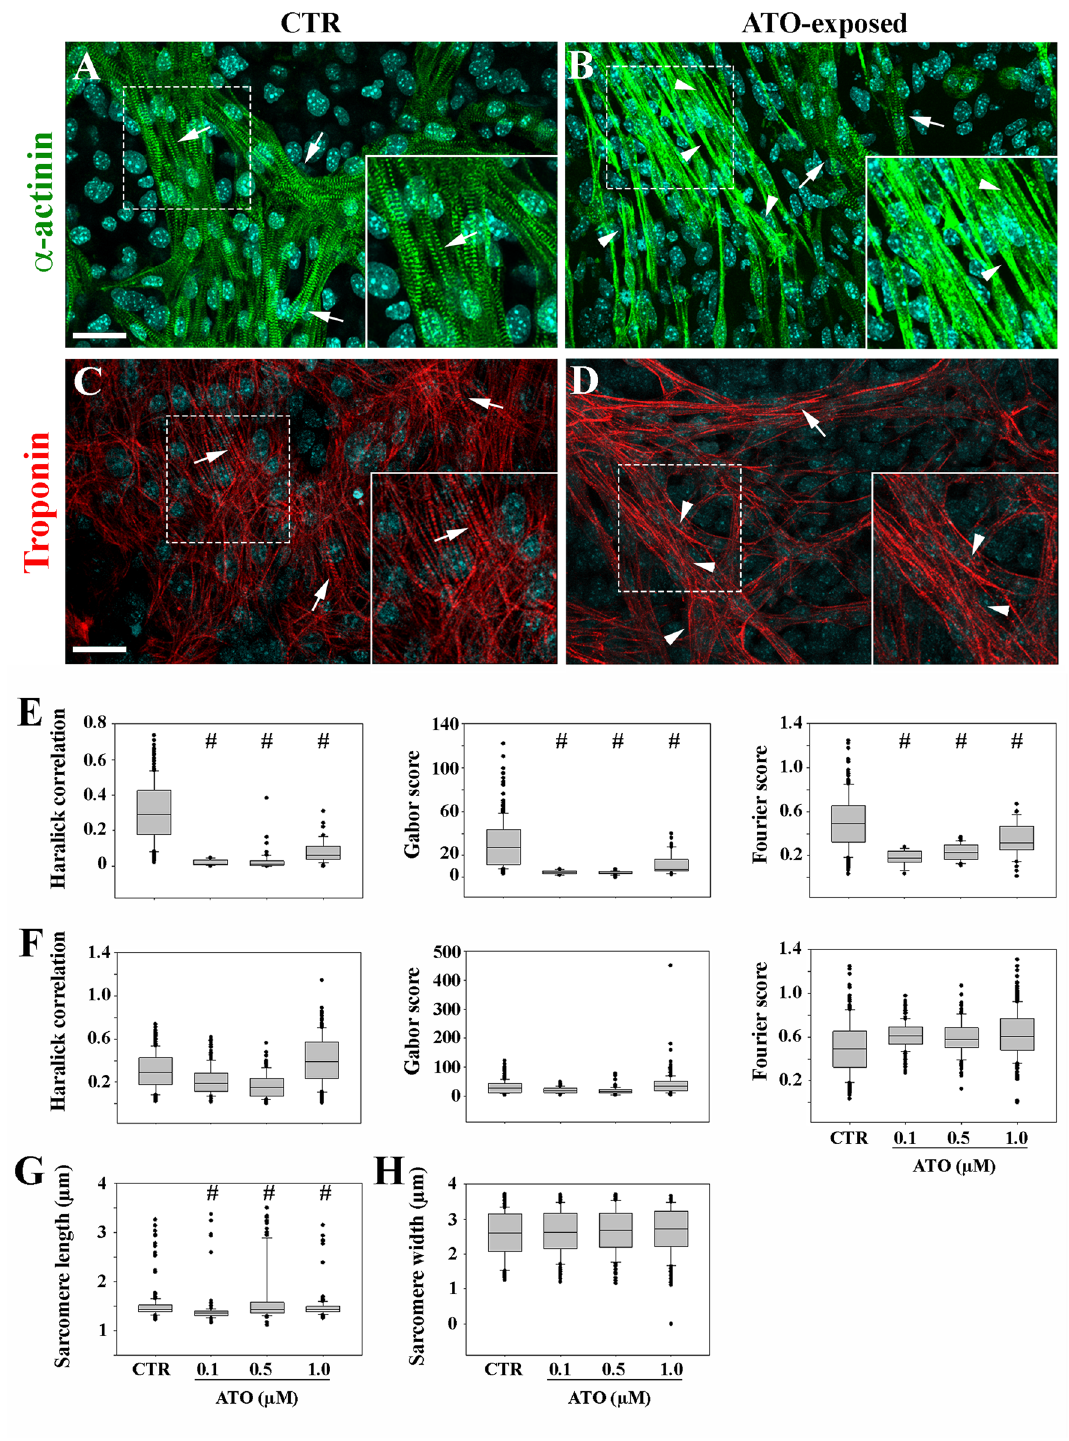
Figure 2. Whole mount immunofluorescence localization of cardiac α-actinin ( A and B ) and of Troponin T ( C and D ) in control (CTR) and in 0.1 µM ATO-exposed cardiomyocytes. White arrows point to correct sarcomere striated pattern ( A , C , magnification in the insets); white arrowheads indicate disorganized sarcomeres ( B , D ) magnification in the insets). Bar: 20 μm. ( E – H ) Quantitative metrics of cardiomyocyte sarcomere structure. ( E ), the three scores refer to the comparison between organized sarcomeres of CTR samples and disorganized altered sarcomeres of ATO-exposed samples; ( F ) the comparison is made between organized sarcomeres present in both CTR and exposed samples. Length ( G ) and width ( H ) of organized sarcomeres in the comparison between CTR and exposed samples. # p <